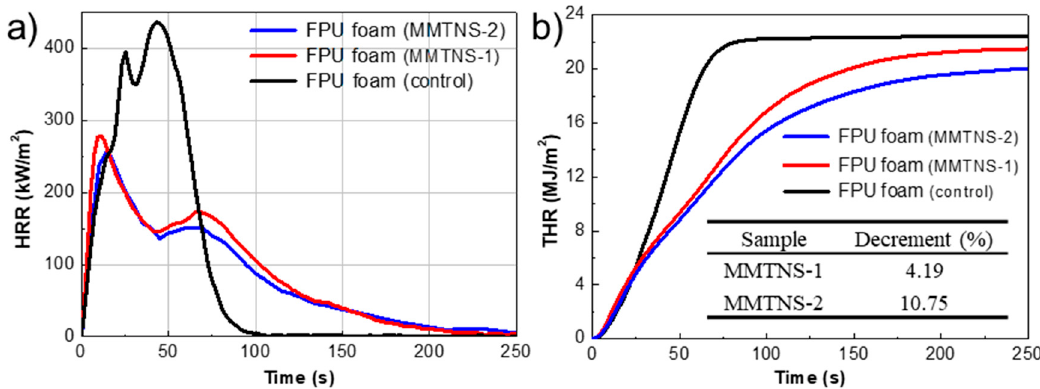
Figure 6. ( a ) Heat release rate (HRR) curves and ( b ) total heat release (THR) curves of control